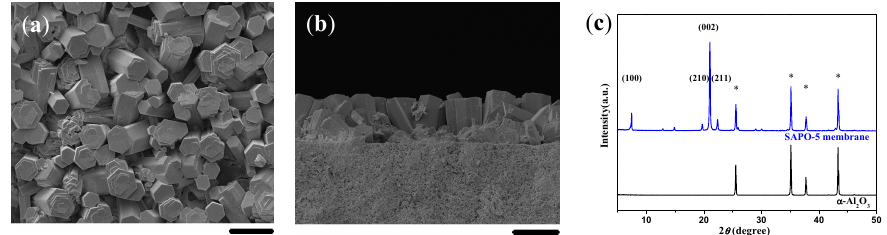
Figure 2. ( a ) Top view and ( b ) cross-sectional SEM images together with ( c ) the corresponding XRD pattern for the single-layer SAPO-5 membrane induced by a layer of LMW chitosan using AIP as the Al source. Scale bars correspond to 20 μ m in SEM images. The asterisks in XRD patterns mark the peaks originating from the α -Al 2 O 3 substrate.